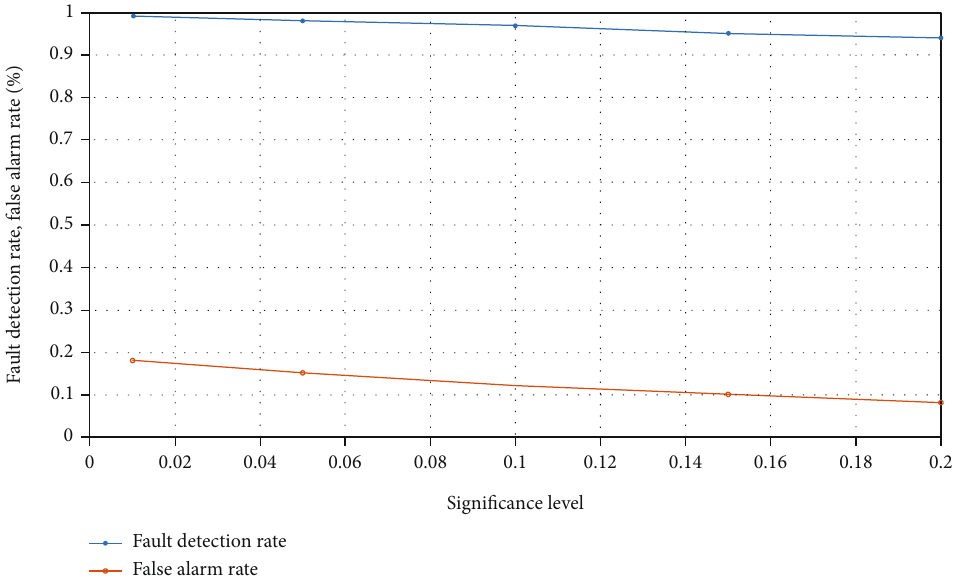
Figure 6: E ff ect of signi fi cance level on fault detection rate and false alarm